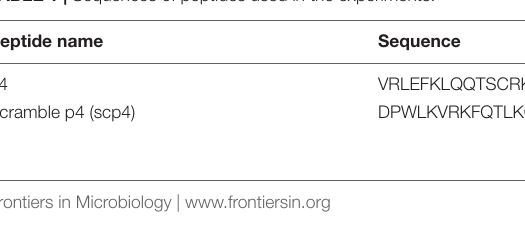
TABLE 1 | Sequences of peptides used in the